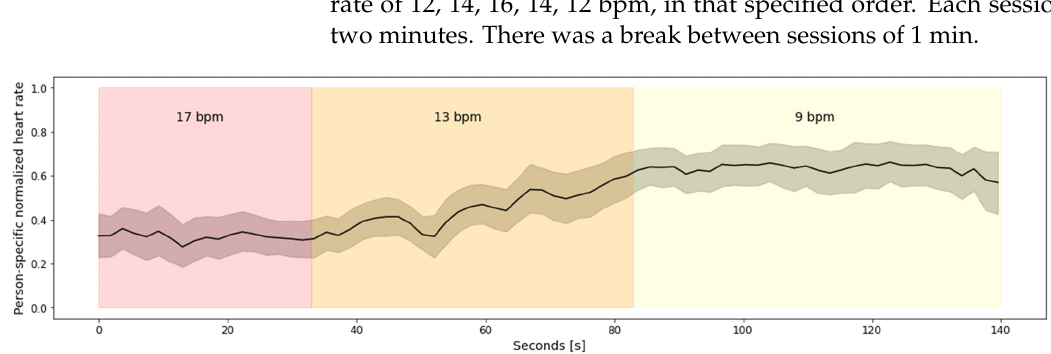
Figure 4. Aggregated heart rate for 27 subjects from Dataset 1. The increase in the heart rate corresponds to the increase in the duration of the guided breaths performed by the subjects.